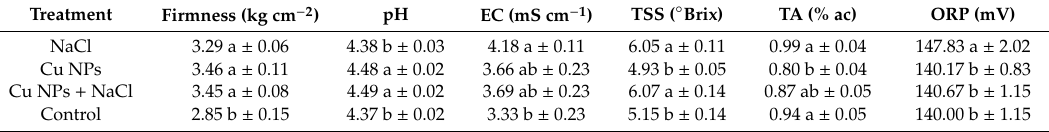
Table 3. Fruit quality of tomato plants under saline stress and foliar application of Cu